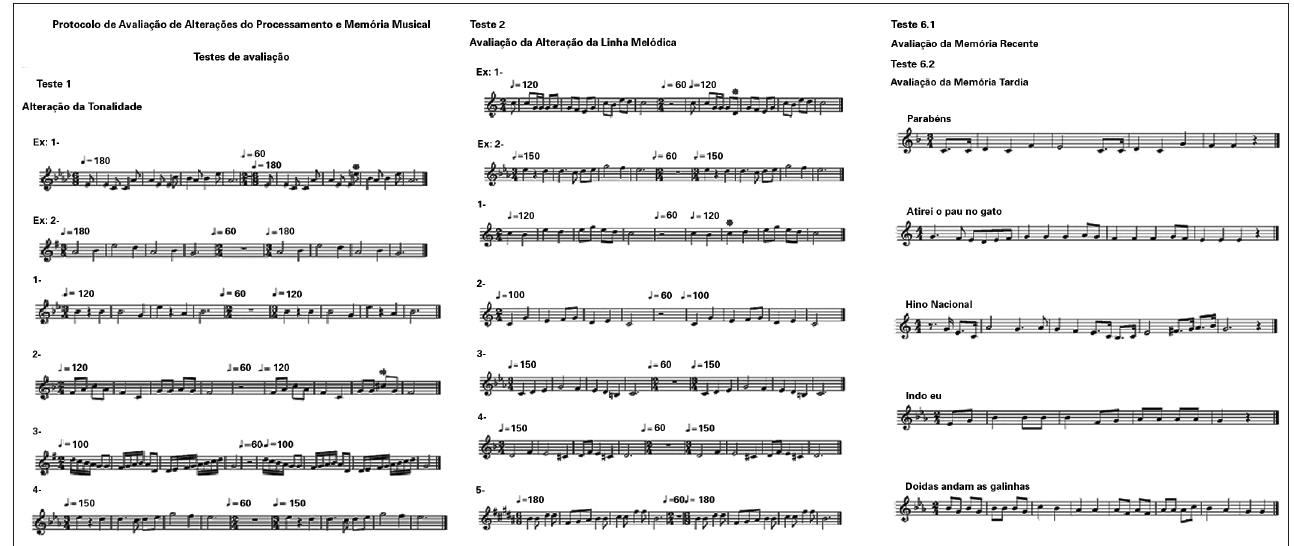
Figura 1. Exemplo do protocolo utilizado na avaliação do processamento da música - parte do teste 1, 2 e